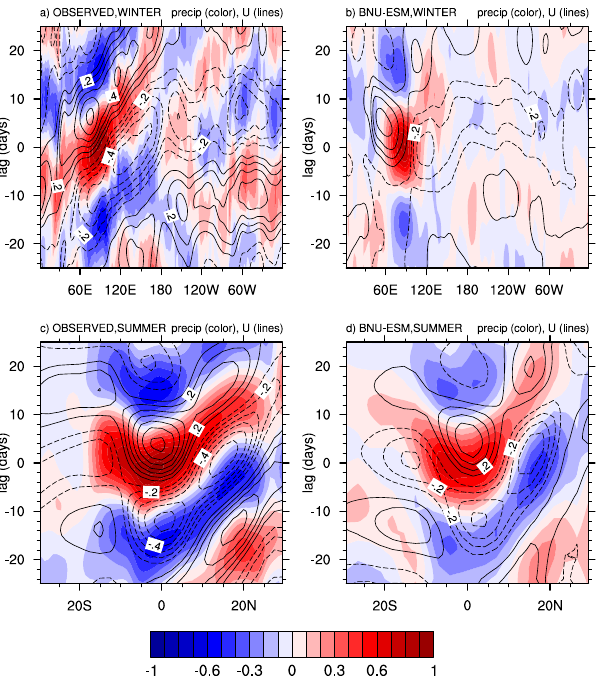
Figure 14. November–April lag-longitude diagram of 10 ◦ S–10 ◦ N averaged intraseasonal precipitation anomalies (colors) and in- traseasonal 850hPa zonal wind anomalies (contours) correlated against intraseasonal precipitation in the Indian Ocean reference region (10 ◦ S–5 ◦ N, 75 ◦ –100 ◦ E) for NCEP observation (a) and BNU-ESM (b) . May–September lag-latitude diagram of 65 ◦ –95 ◦ E averaged intraseasonal precipitation anomalies (colors) and in- traseasonal 850hPa zonal wind anomalies (contours) correlated against intraseasonal precipitation at the Indian Ocean reference re- gion for NCEP observation (c) and BNU-ESM (d) . The averaging period is 1980–2005 for BNU-ESM historical run, and 1997–2006 for observations.